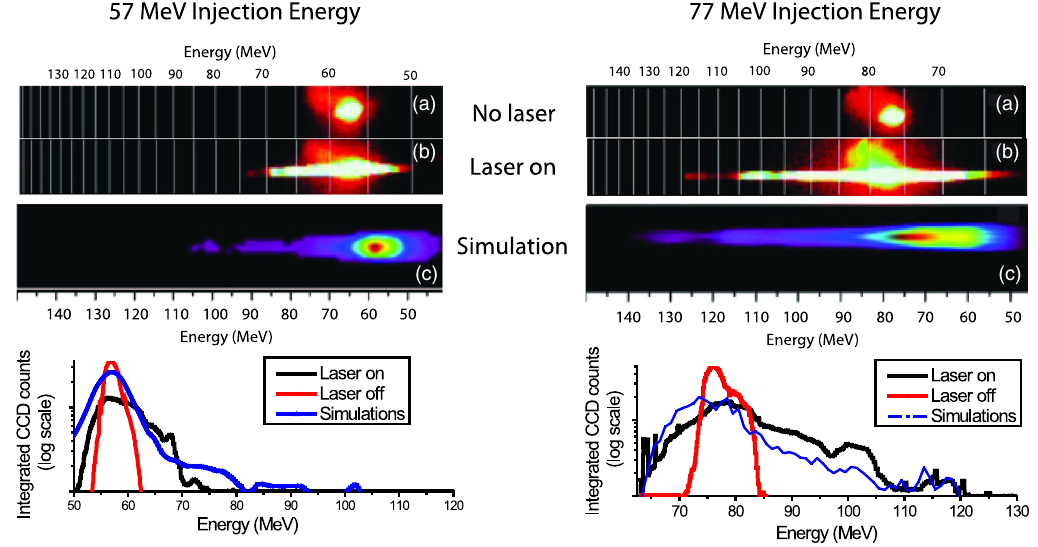
FIG. 5. IFEL spectra for 57 MeV (left) and 77 MeV (right) injection energies. (a) no laser, (b) laser on, (c) GPT simulation results. Integrated lineouts of the spectra are also